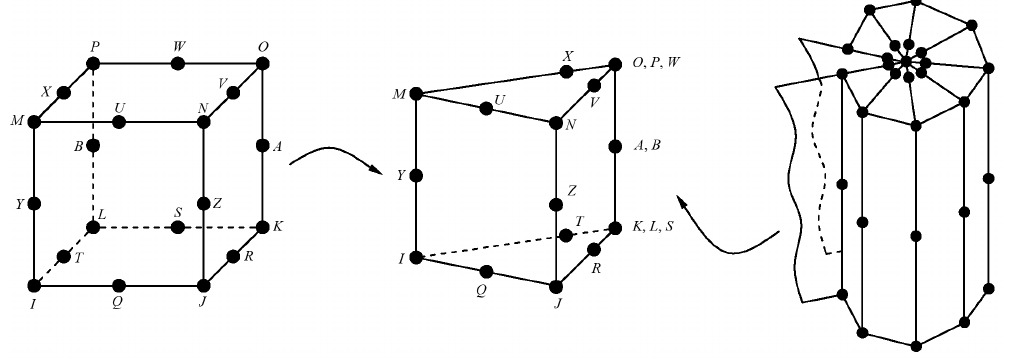
Figure 3. A singular element of the three-dimensional crack model